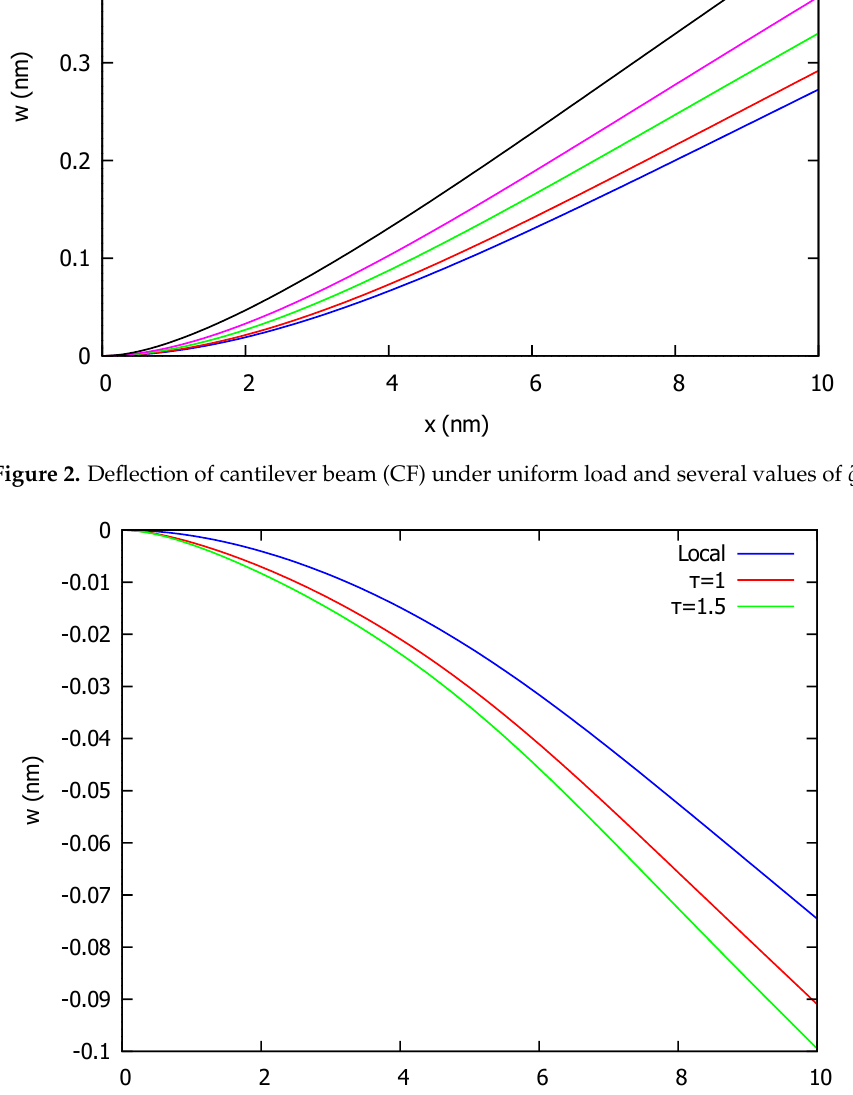
Figure 3. Deflection of cantilever beam (CF) under variable load and different values of τ . As a third example, we take the case of a clamped beam (CC) for which the boundary conditions are given in (42). In the case of a uniformly distributed load, the deflection w ( x ) across the beam in both local ( ξ 1 = 1) and nonlocal ( ξ 1 = 0.1) theory for different values of τ = e 0 a is given in Figure 7, while Figure 8 shows how the deflection changes as ξ 1 varies. In the case of the above variable distributed load q ( x ) with n = 3, the beam deforms as shown in Figure 9 in a local ( ξ 1 = 1) and nonlocal ( ξ 1 = 0.2) model for different values of the nonlocal parameter τ